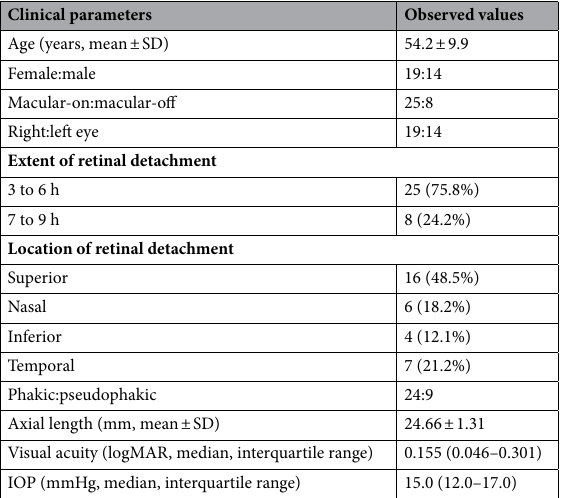
Table 1. Preoperative baseline clinical characteristics of eyes with retinal detachment (n = 33). Values are presented as number, mean ± standard deviation, or median (interquartile range). SD Standard deviation, logMAR Logarithm of the minimum angle of resolution, IOP Intraocular pressure.